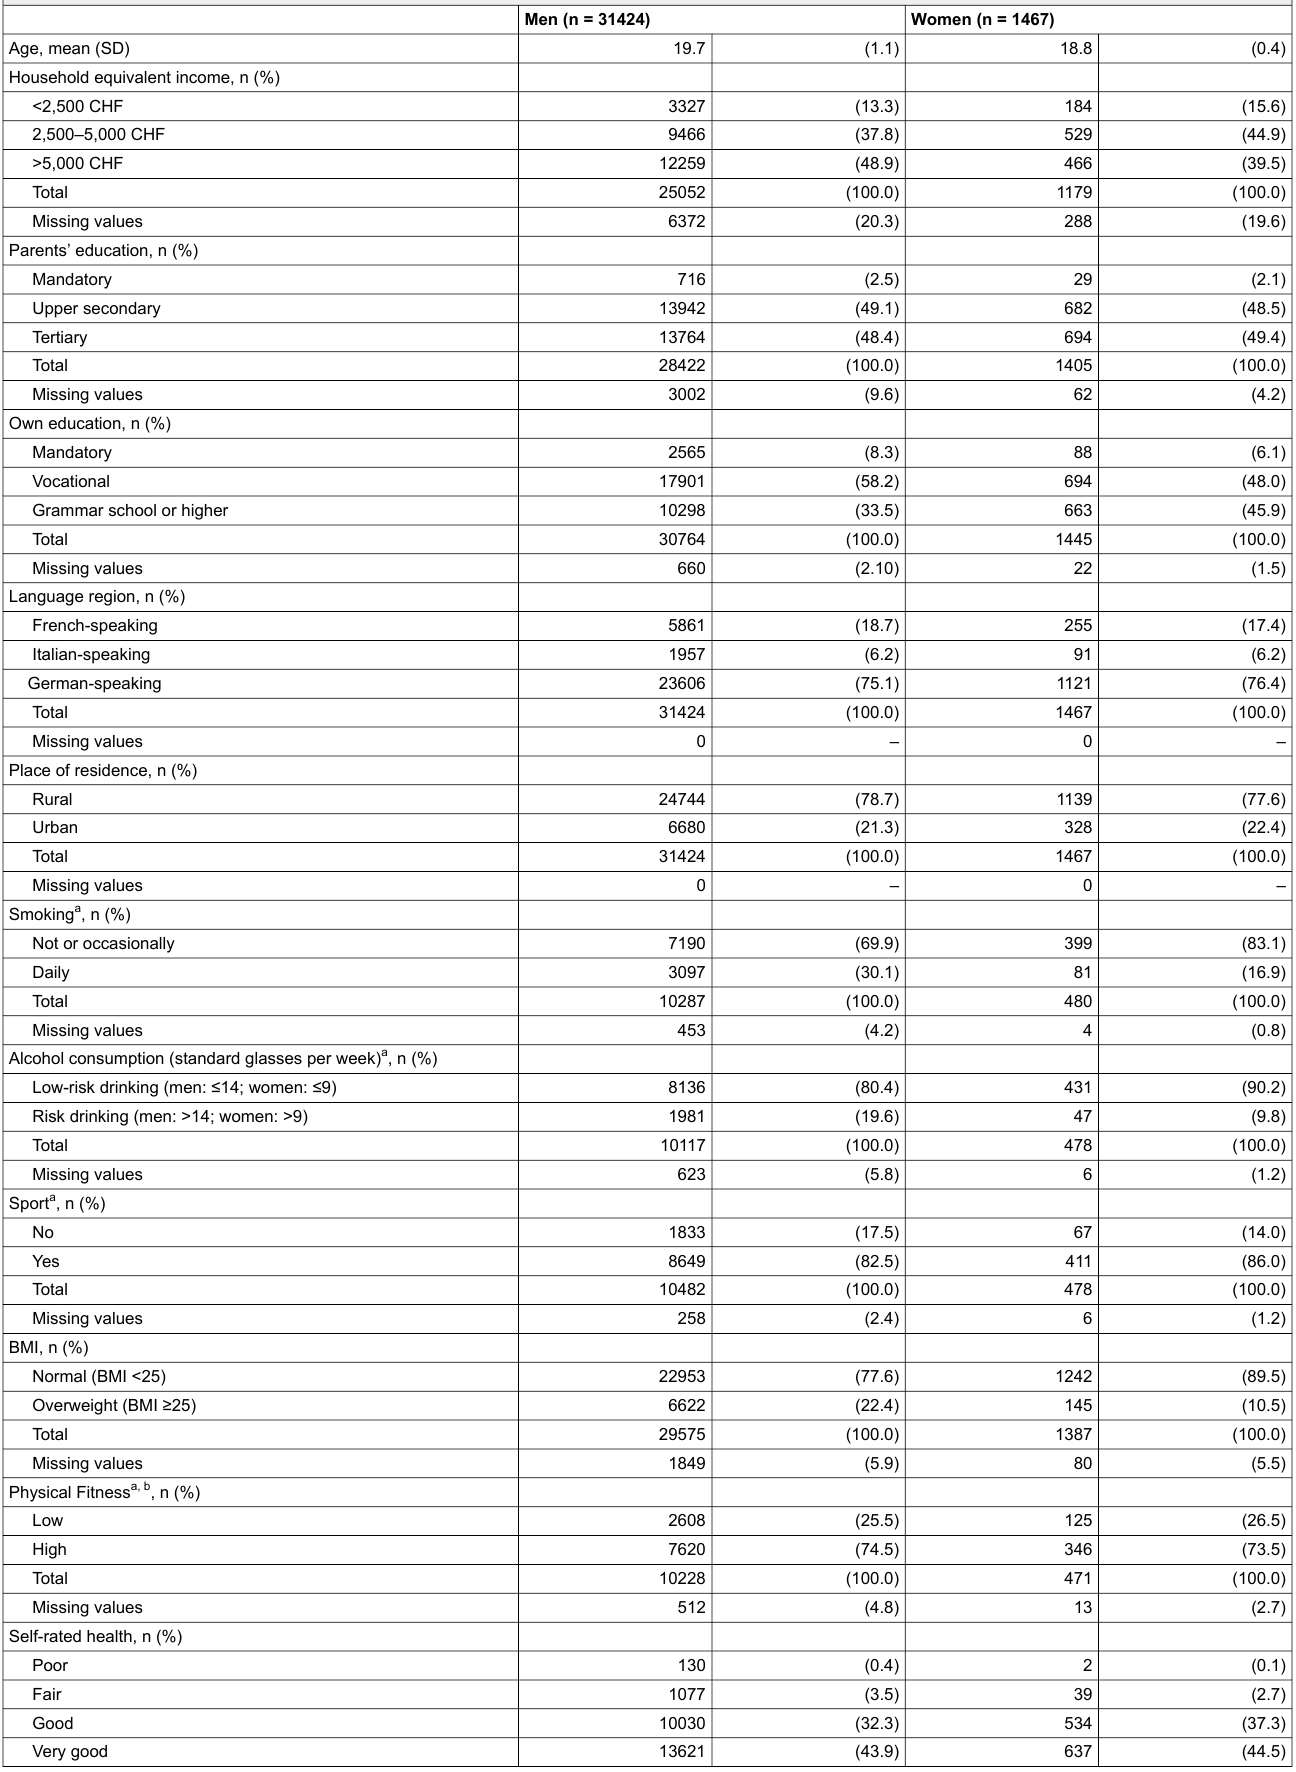
Table 1: Sample characteristics. Interval variables are presented as mean and standard deviation (SD), categorical variables are presented as percentages